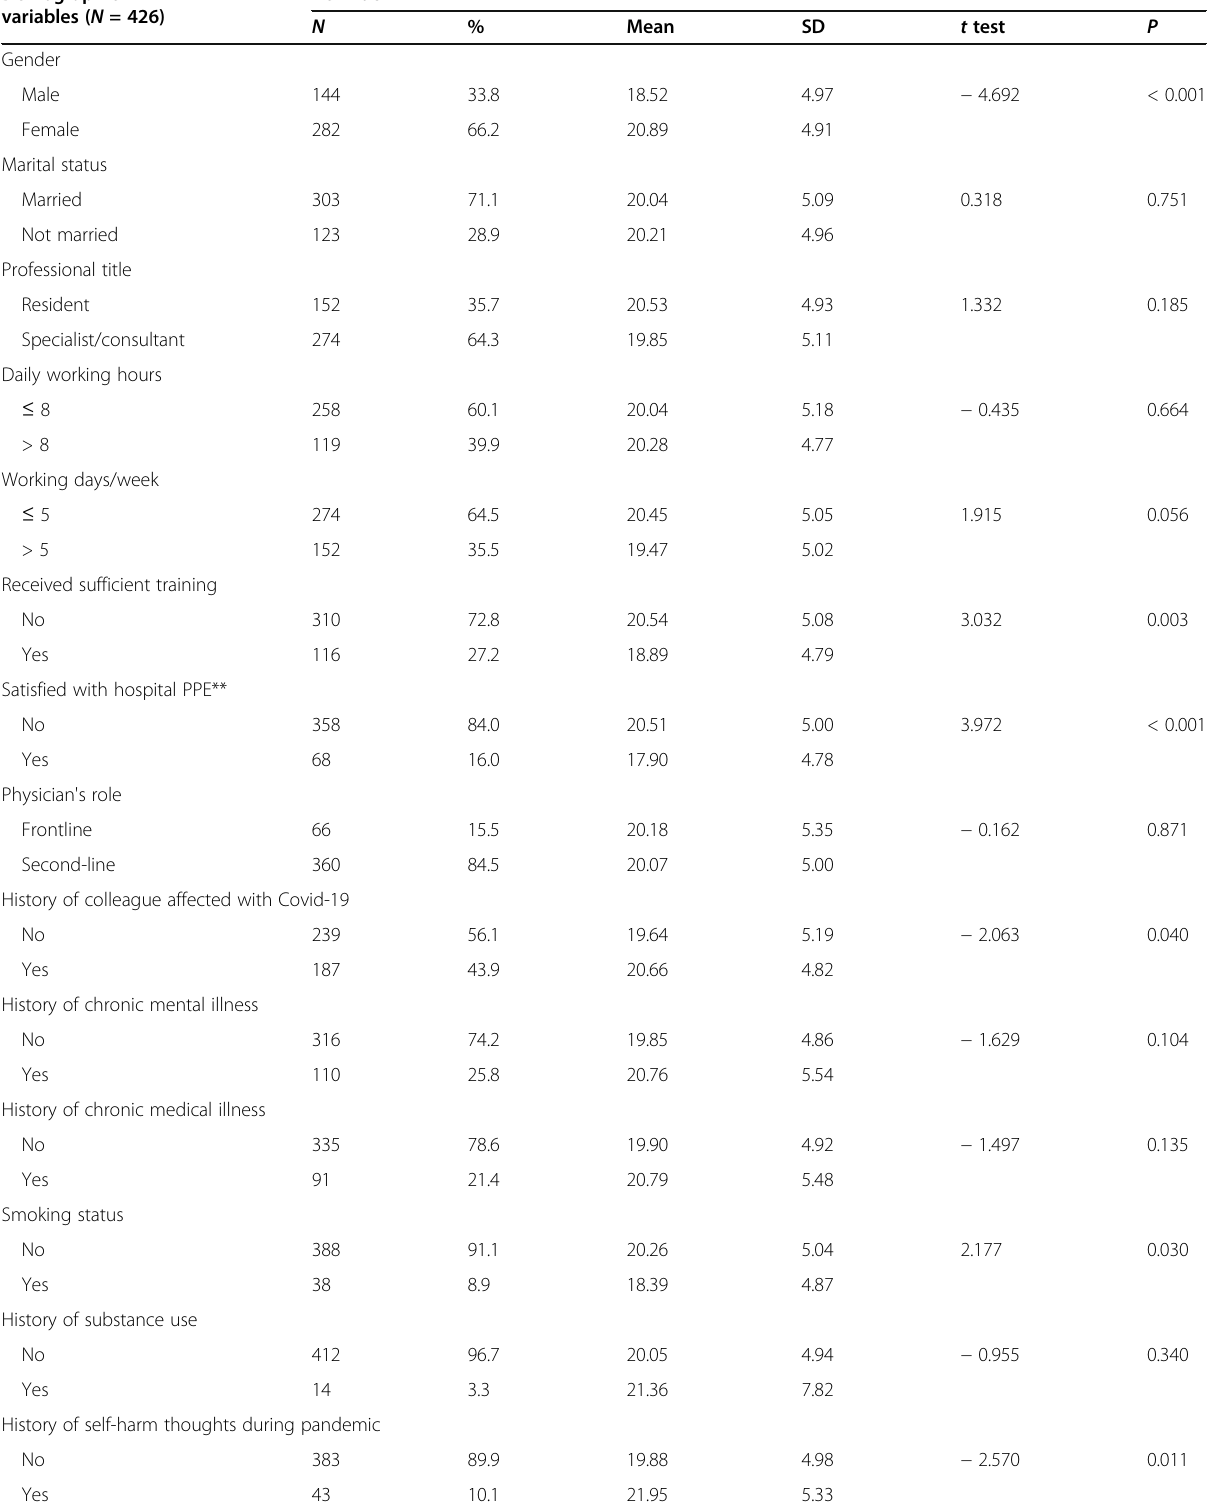
Table 1 Association between the score of FCV-19S and physicians' demographic and clinical characteristics Demographic variables ( N =